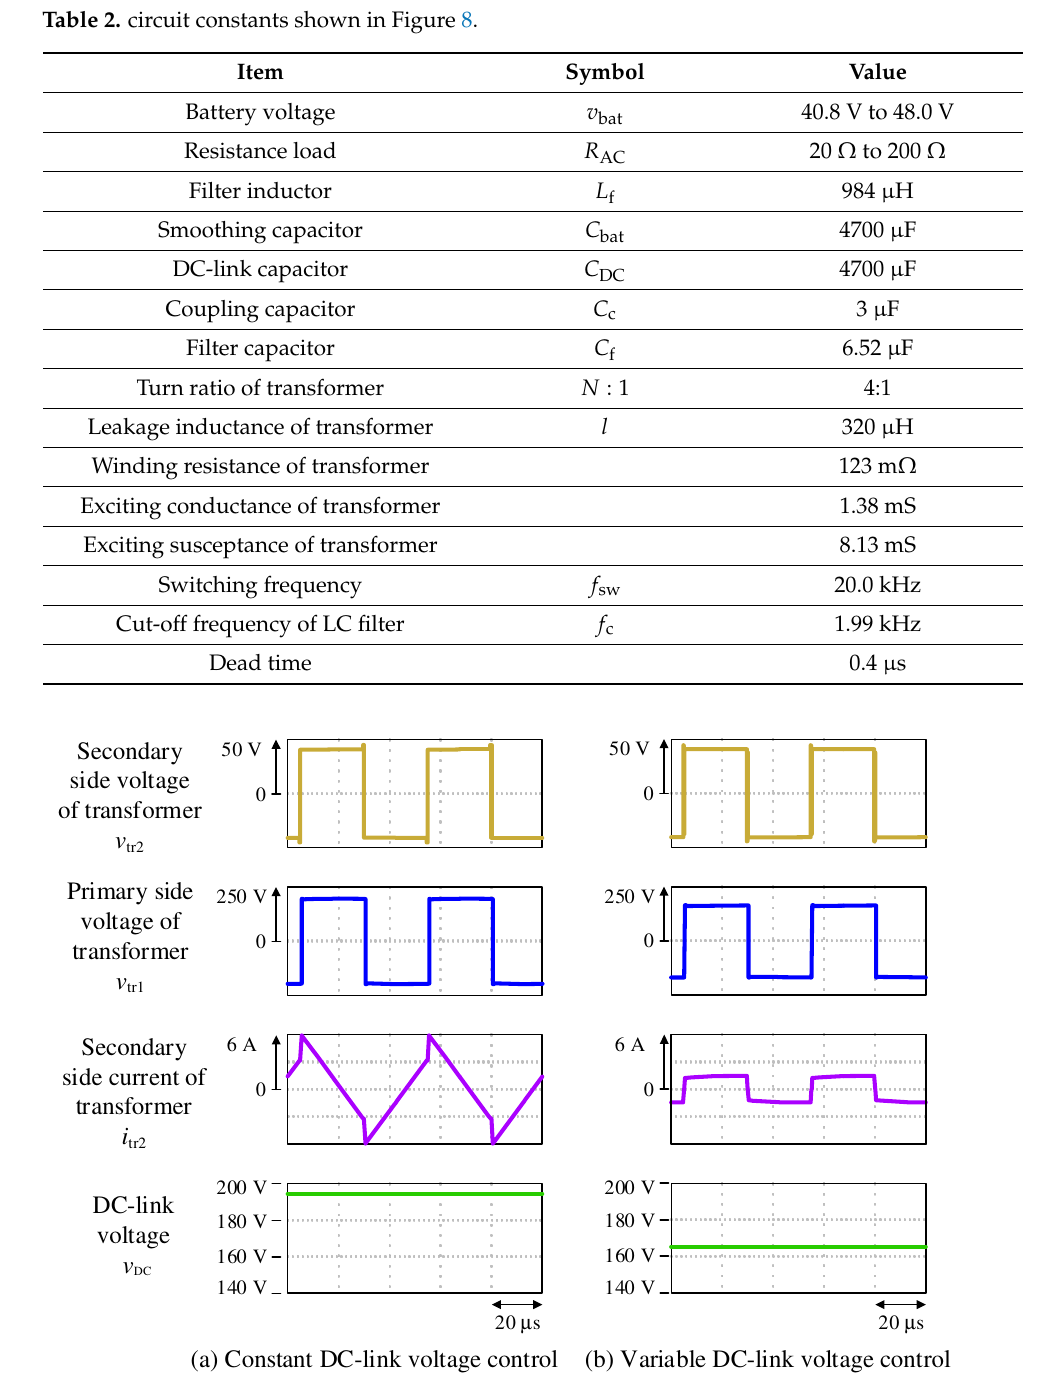
Figure 9. Simulation waveforms of DAB converter when p bat = 50 W (10%) and v bat = 40.8